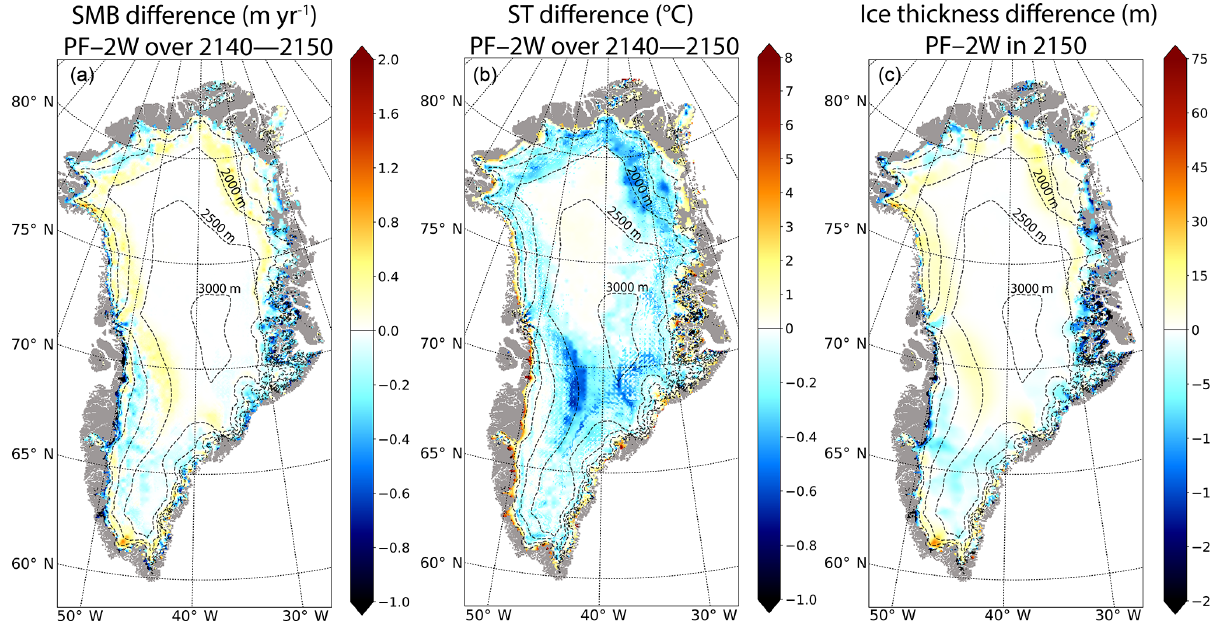
Figure 10. Mean differences (PF–2W) for the 2140—2150 mean period (a) annual surface mass balance (in myr − 1 ), (b) annual surface temperature (in ◦ C) and (c) ice thickness (inm) in 2150 between PF and 2W. Note that these differences are computed on the GRISLI grid. The dashed lines correspond to the 500m surface elevation iso-contours of the present-day observed topography. The grey shading represents the non-ice-covered areas.